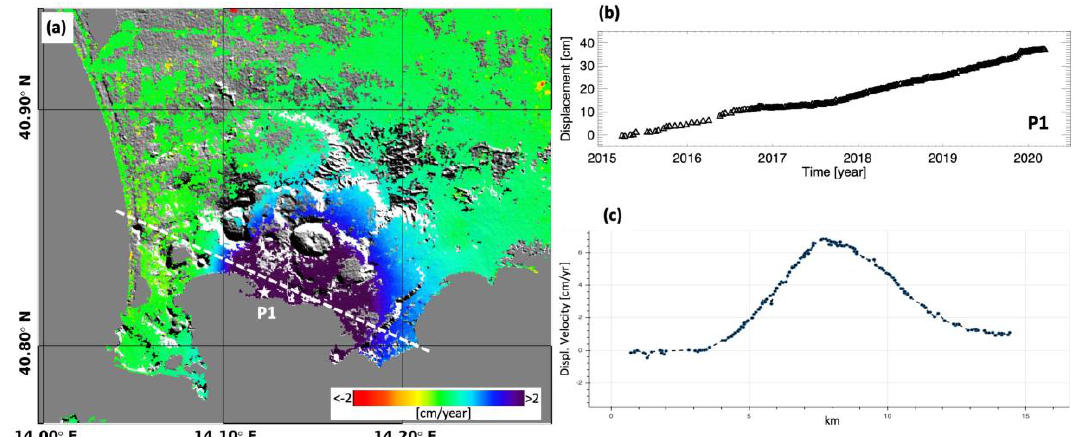
the maximum displacement located in the Rione Terra area (P1 in Figure 13a).